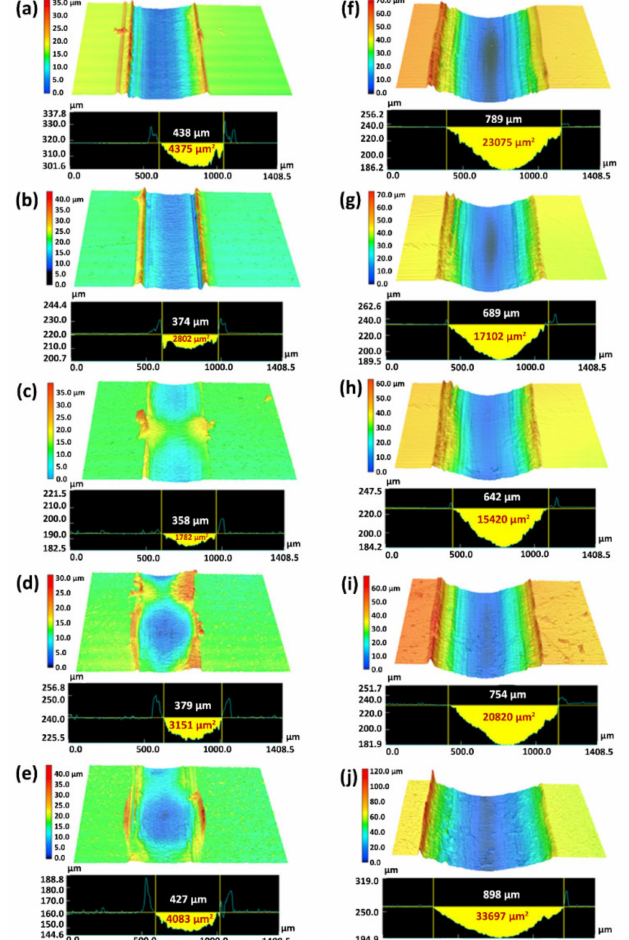
Figure 5. The 3D morphologies and profile of wear track: ( a ) pure PI, ( b ) 0.25 FG/PI, ( c ) 0.5 FG/PI, ( d ) 1.0 FG/PI, ( e ) 2.0 FG/PI under dry friction condition and ( f ) pure PI, ( g ) 0.25 FG/PI, ( h ) 0.5 FG/PI, ( i ) 1.0 FG/PI, ( j ) 2.0 FG/PI under seawater lubrication condition (Reproduced with permission